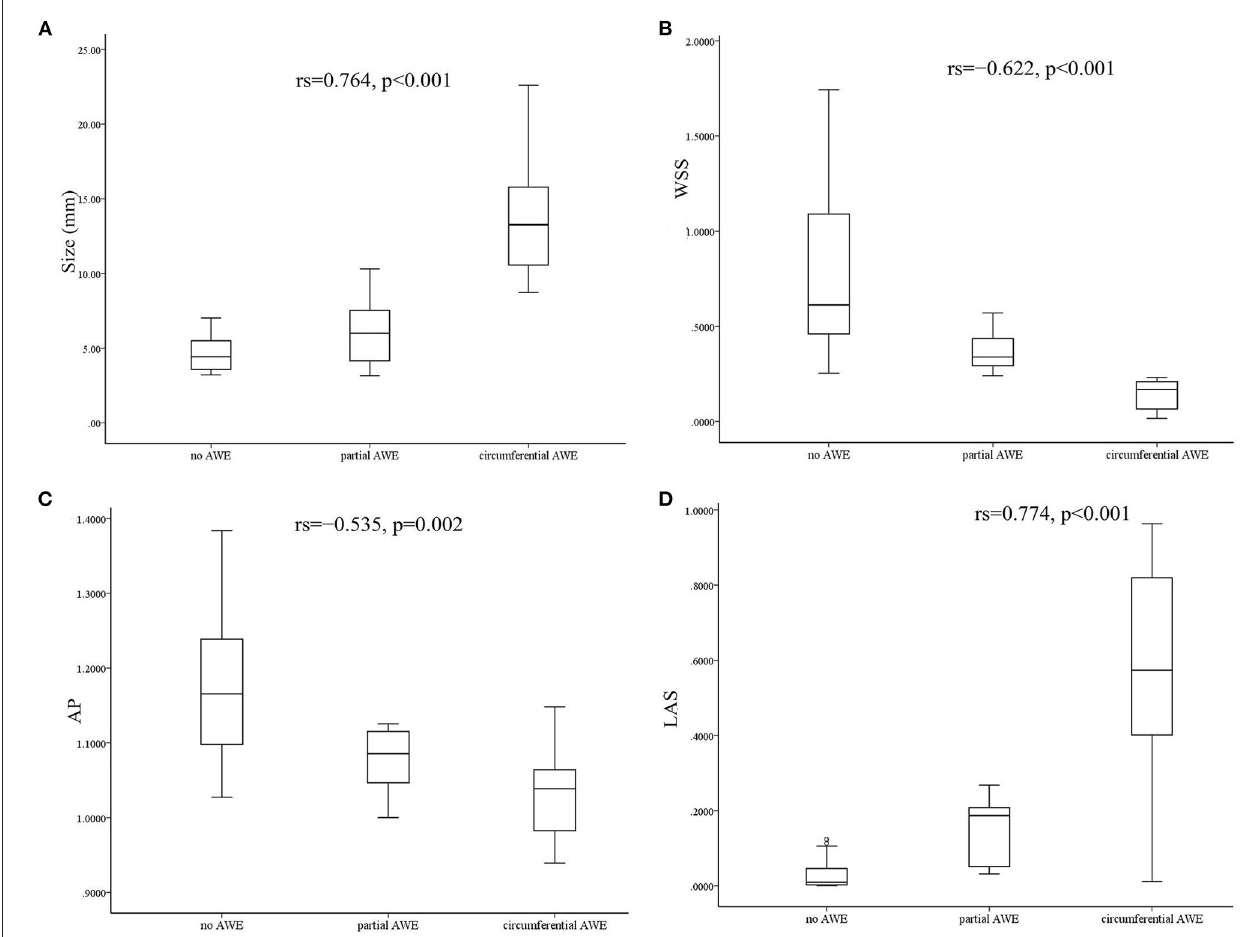
FIGURE 2 | Box diagram and Spearman’s correlation analysis showed that aneurysm size was positively correlated with aneurysm wall enhancement (AWE) (A) . Wall shear stress (WSS) was negatively correlated with AWE (B) . Aneurysm pressure (AP) was negatively correlated with AWE (C) , and low shear area (LSA) was positively correlated with AWE (D) .